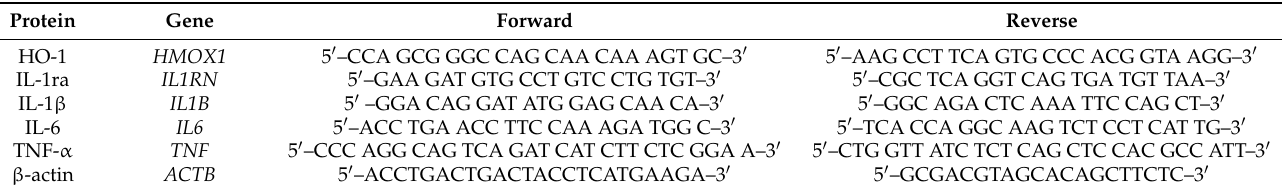
Table 1. Sequences of the primers used for